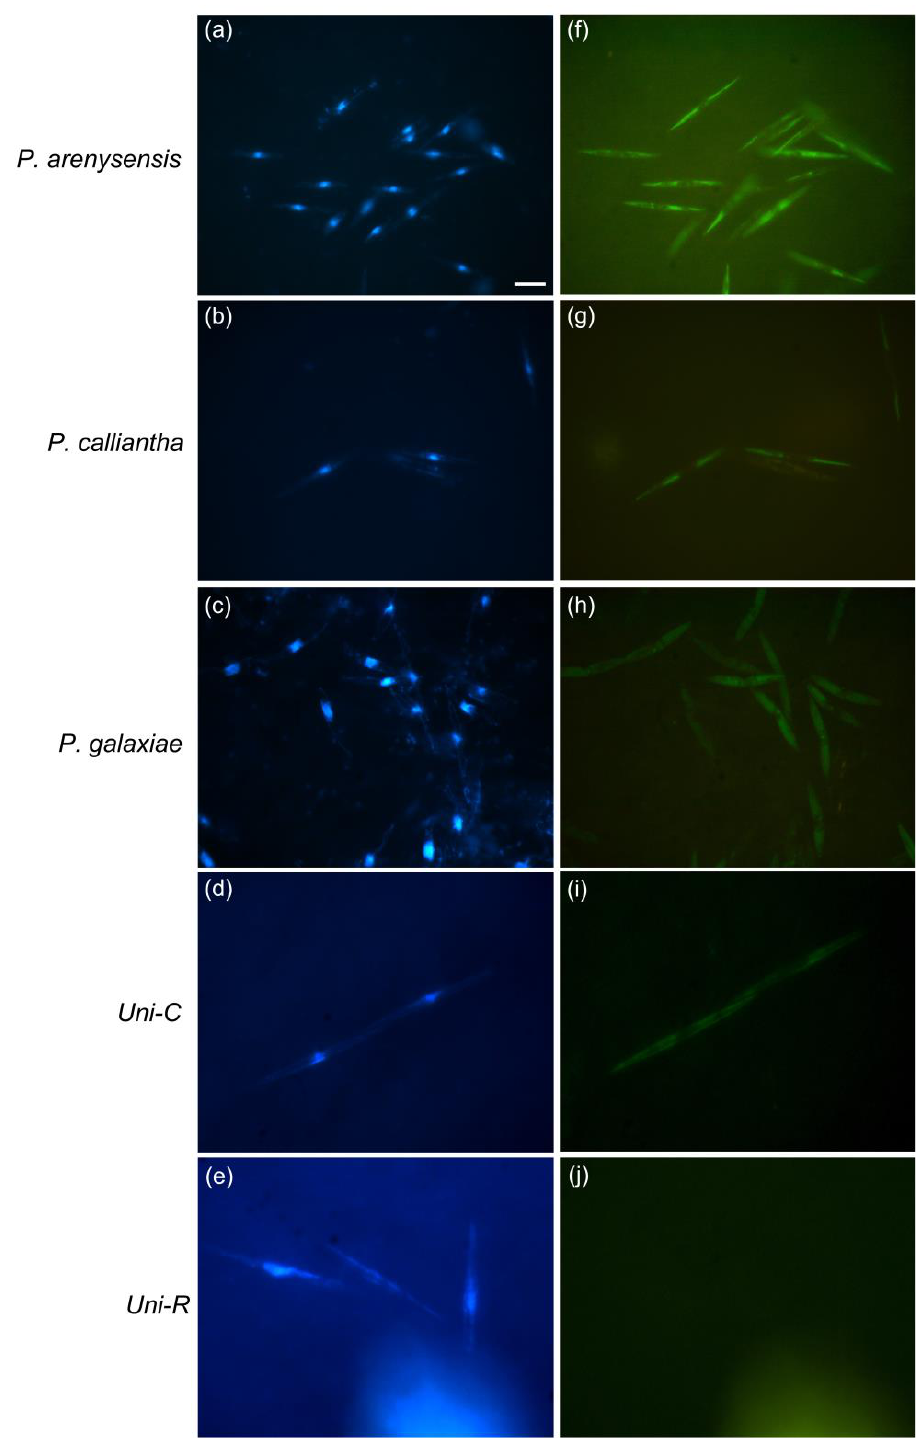
Figure 1. Images of WC-FISH assays of pure culture of some cryptic Pseudo-nitzschia species hybridised to their species-specific probes. Each row of micrographs displays cells of pure cultures under epifluorescence microscopy in DAPI ( a – e ) and FITC ( f – j ) filters. The last two rows of micrographs display the hybridization with Uni-C (positive control) ( d,i ) and Uni-R (negative control) ( e,j ) probes. Scale = 10 μm.